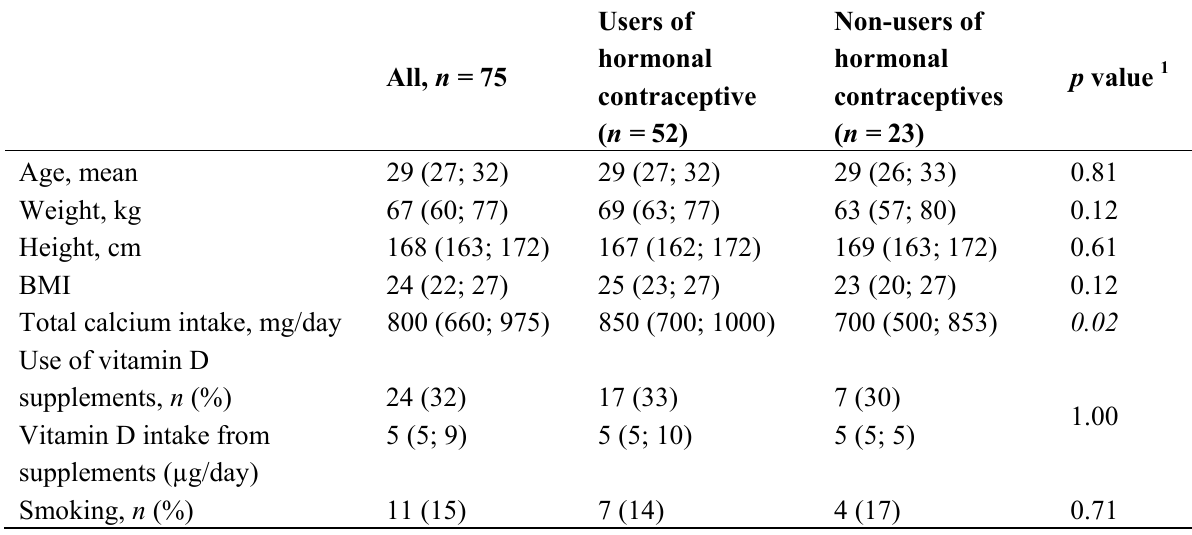
Table 1. Characteristic of the 75 studied women stratified by use of hormonal contraceptives. Median with interquartile (p25; p75) ranges unless otherwise indicated.